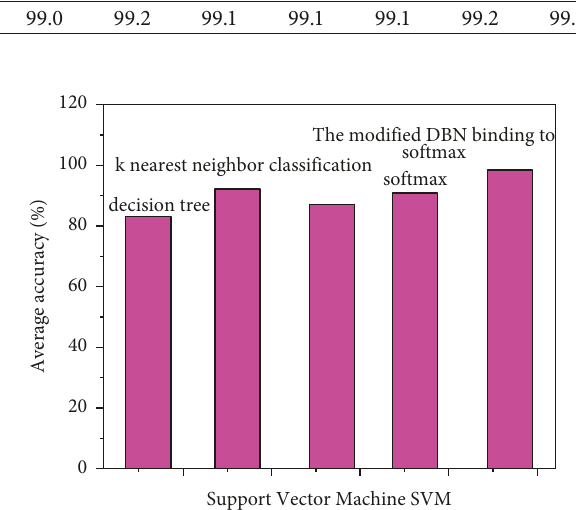
Table 6: Prediction accuracy of Chinese traditional musical instruments with different neuron nodes in three hidden layers. Number of hidden layer nodes in the third layer